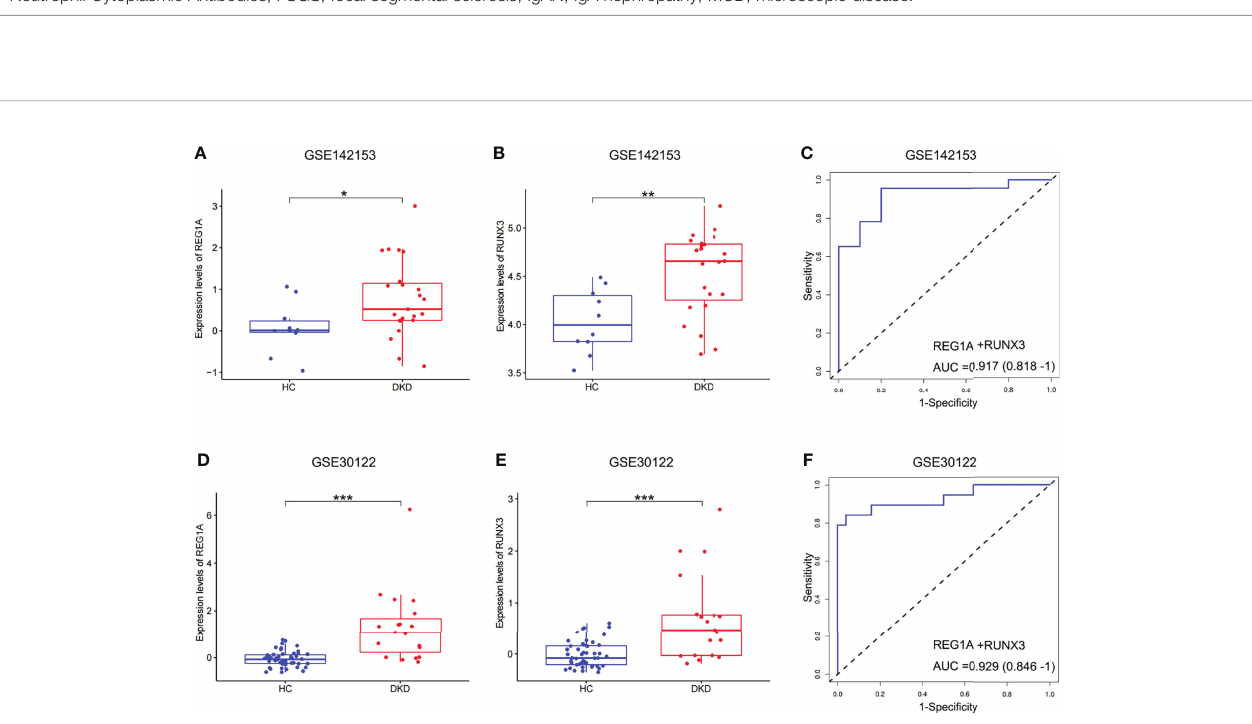
FIGURE 5 | Expression and validation of diagnostic marker ef fi cacy in developmental cohorts. (A, B) Box plots showed that the expression levels of REG1A and RUNX3 were signi fi cantly higher in blood samples (DKD vs. HC, rank sum test). (C) ROC curve of the combined diagnostic ef fi cacy of REG1A and RUNX3 in blood samples. (D, E) Box plots showed that the expression levels of REG1A and RUNX3 were signi fi cantly higher in the kidney samples (DKD vs. HC). (F) ROC curve of the combined diagnostic ef fi cacy of REG1A and RUNX3 in kidney samples. *p <0.05, **p <0.01, ***P